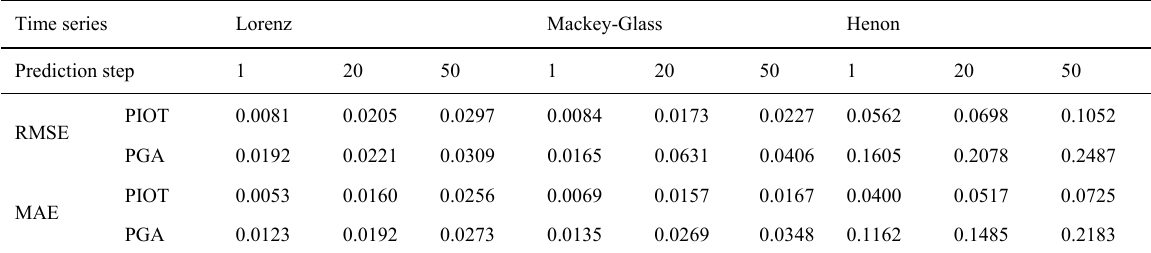
Table 3. The prediction error comparison of chaotic time series.